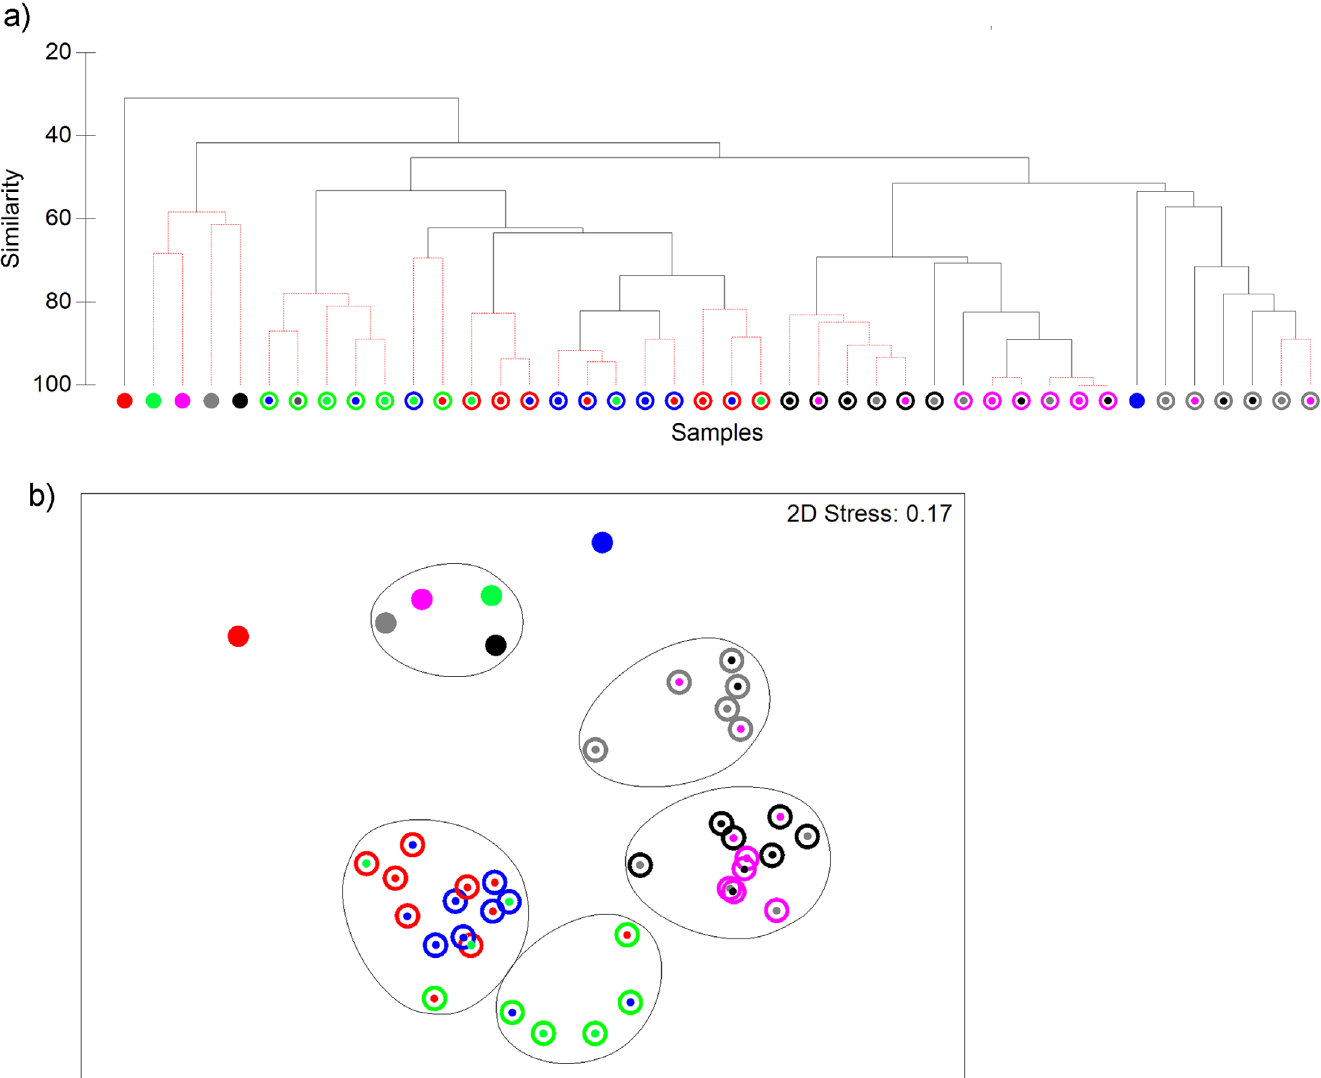
Fig 3. Eubacterial DNA profiles of saliva from six volunteers (indicated by red, green, pink, blue, grey and black colours) analysed by cluster analysis (a) and non-metric MDS (b). Closed circles, whole saliva, open circles, saliva eubacterial fractions selected by antibodies from volunteers as indicated by coloured centre spots. DNA profiles differed significantly between individuals for microbiota (P (cid:1) 0.001%, R = 0.475); between microbiota selected by self vs non-self-antibodies (P (cid:1) 0.001, R = 0.42); according to microbiota and immunoglobulin origin (P (cid:1) 0.001, R = 0.63), but not immunoglobulin isotype (p = 0.2, R = 0.029). Robustness of clusters (p (cid:1) 0.05) is indicted in red, based on the SIMPROF test in PRIMER v6. Contour lines on the MDS plot superimpose 55% resemblance levels derived from cluster analysis.